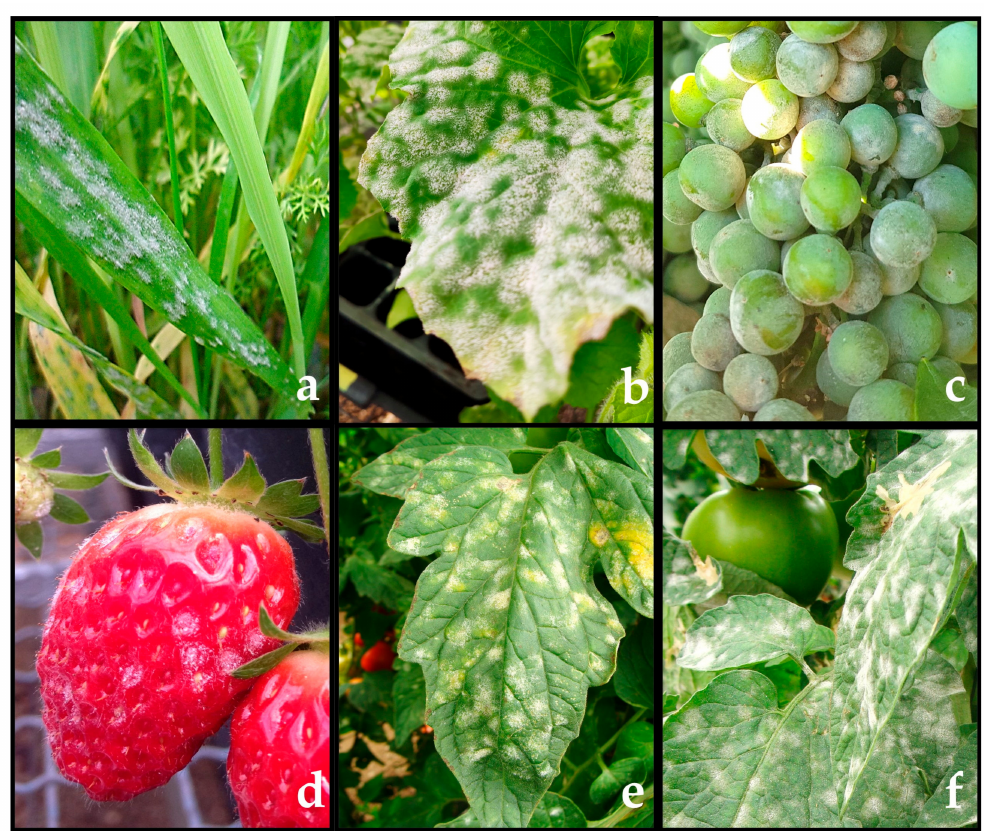
Figure 1. Typical powdery mildew symptoms observed on leaves and fruits of several crops. ( a ) wheat powdery mildew, caused by Blumeria graminis f. sp. tritici ; ( b ) cucurbit powdery mildew, caused by Podosphaera xanthii ; ( c ) grape powdery mildew, caused by Erysiphe necator ; ( d ) strawberry powdery mildew, caused by Podosphaera aphanis ; ( e , f ) tomato powdery mildew, caused by Leveillula taurica and Oidium neolycopersici, respectively. Picture “a” was taken from Mourad Louadfel (Homemade, Bugwood.org), pictures “b and d” were provided by the authors of this review, picture “c” was kindly provided by Beatriz L ó pez Manzanares (Instituto de Ciencias de la Vid y del Vino, Spain), picture “e” and “f” were kindly obtained from Pedro Vega (Syngenta,